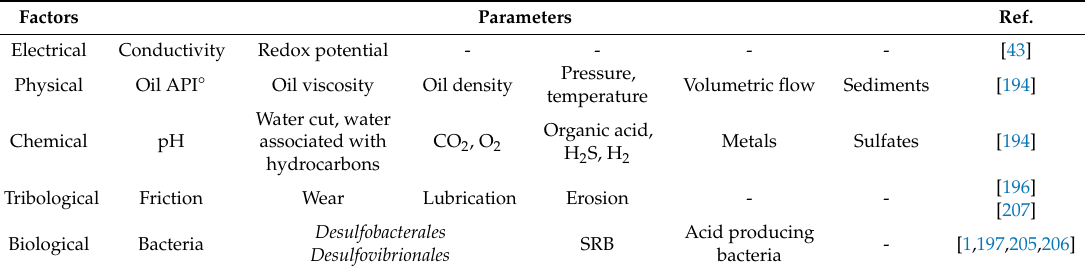
Table 7. Main internal environments a ff ecting operating pipelines to develop SCC.